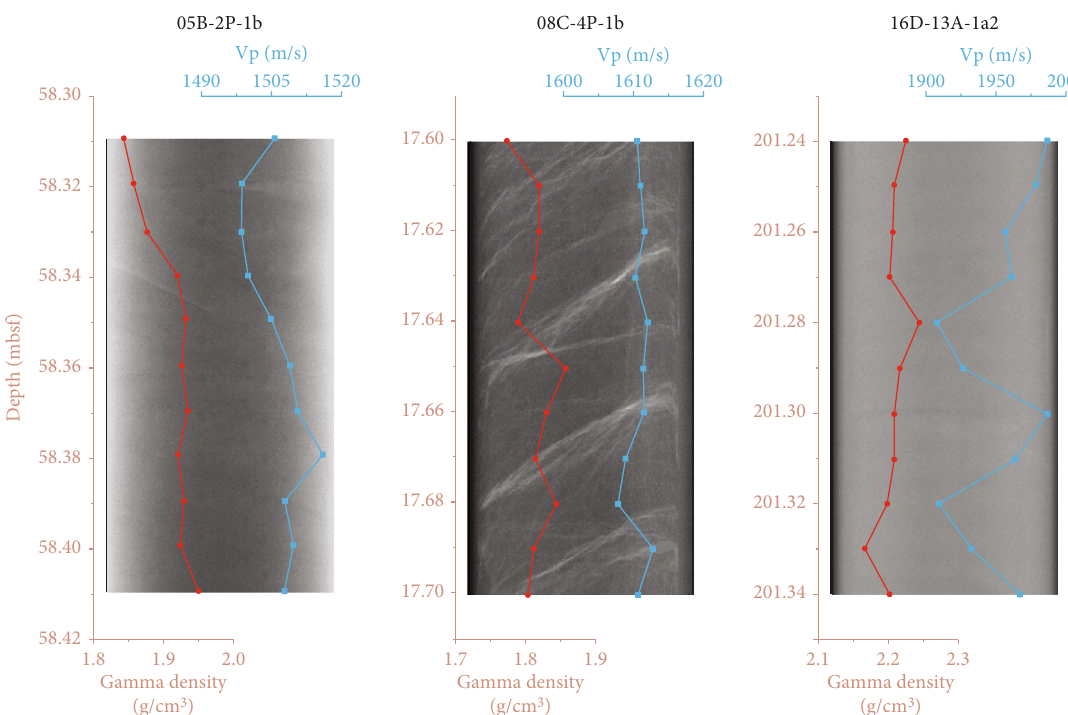
Figure 3: Typical gamma density (red dot), P-wave velocity (blue dot), and X-ray images of the